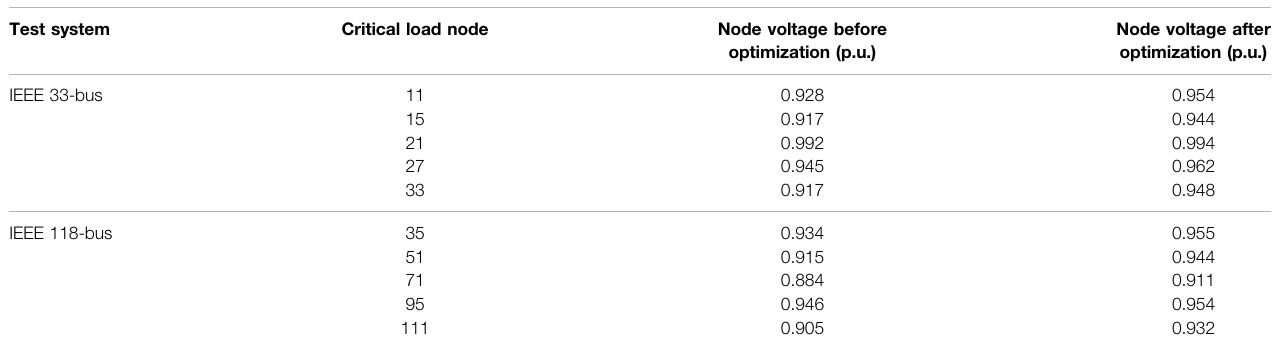
TABLE 3 | The voltage comparison of the critical loads before and after optimization. Test system Critical load node Node voltage before